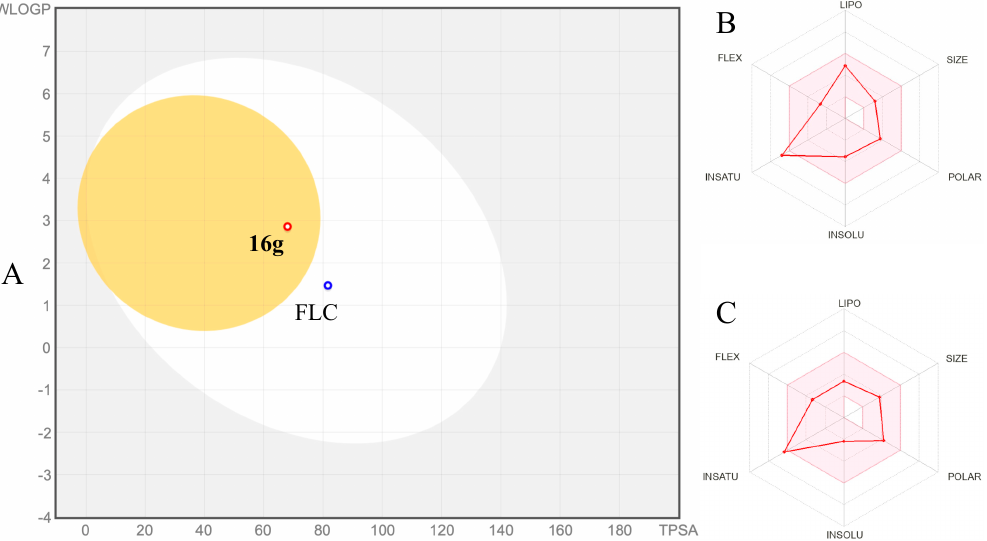
Figure 7. ( A )The BOILED-Egg model prediction of 16g and FLC; ( B ) Bioavailability radar for 16g ; ( C ) Bioavailability radar for FLC; FLC: fluconazole.